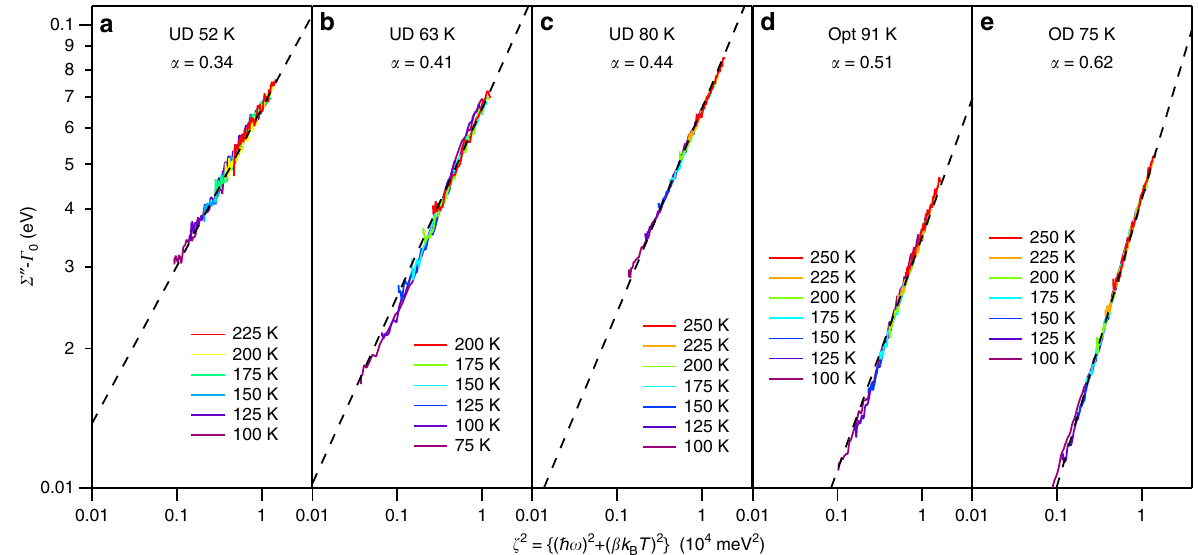
Fig. 2 Imaginary self energy (with Γ 0 subtracted off) for different doped samples vs. ζ 2 = {( (cid:1) h ω ) 2 + ( β k B T ) 2 }. a – e Imaginary self-energy curves Σ ” − Γ 0 at multiple temperatures for 5 different samples, all collapse onto single lines with different power law component α . On this log – log plot a power law function is perfectly linear, with the slope of the lines giving the Power Law Liquid exponent α . β values for each sample were taken from Fig. 1b, i.e. were ∼ π .